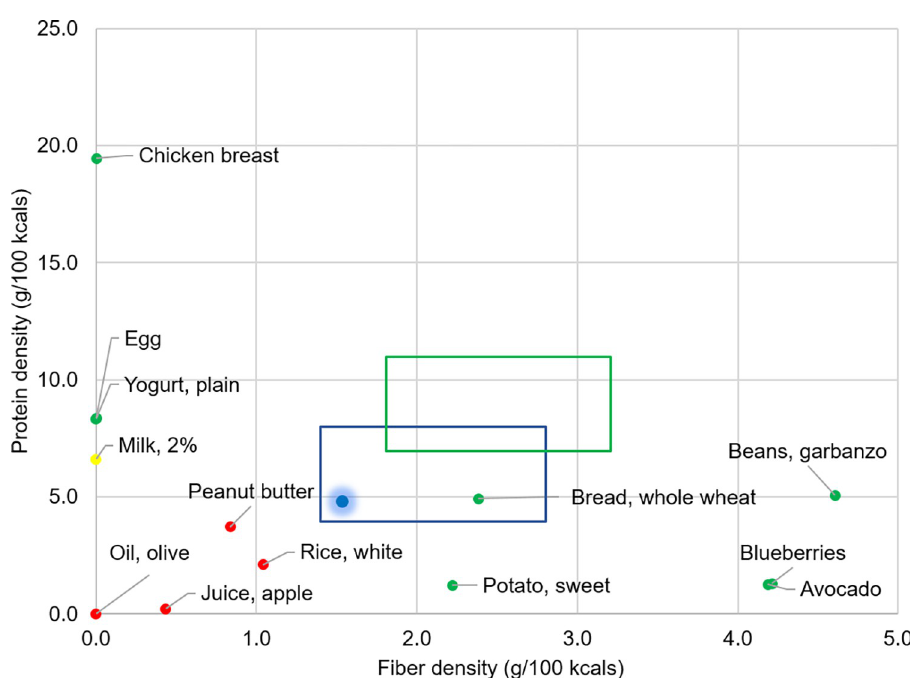
Fig 2. Protein and fiber plot with example food items. Foods with green dots are dense in protein or fiber and can be easily fit in the target box when combined, whereas foods with red dots cannot be due to low protein and fiber densities. A yellow food has protein and fiber density between green and red foods. A blue dot with a shadow shows where a meal falls when all foods are combined. Blue box, weight maintenance target; green box, weight loss